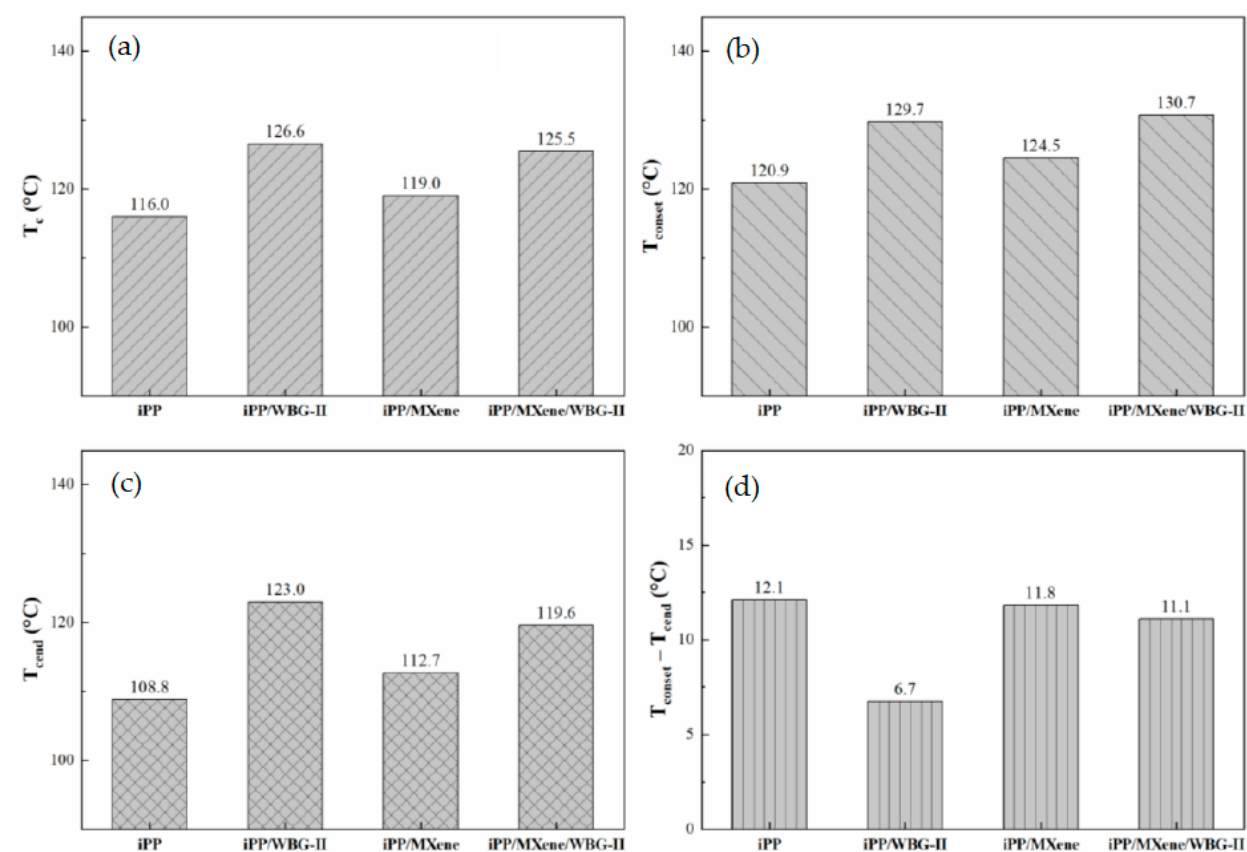
Figure 5. Plots of ( a ) T c , ( b ) T conset , ( c ) T cend , ( d ) T conset − T cend of four samples from the cooling curve at T end = 50